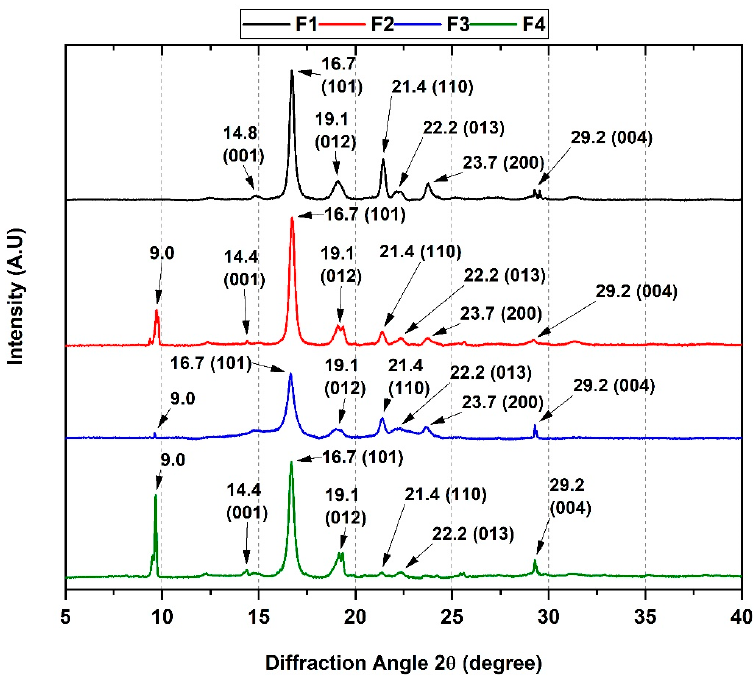
Figure 8. XRD analysis of PCL/PLA/ZnO-NPs/Gly/TTEO nanocomposites. F1, 25%PCL/70%PLA/5%Gly; F2, 22%PCL/70%PLA/5%Gly/3%ZnO-NPs; F3, 15%PCL/70%PLA/5%Gly/10%TTEO; F4, 17%PCL/70%PLA/5%Gly/3%ZnO-NPs/10%TTEO. On the other hand, changes in the crystallinity of the F2, F3, and F4 membranes were observed. Firstly, adding ZnO-NPs promotes degradation by decreasing the nucleation processes, generating greater mobility of the polymer chains, and causing new diffraction sites such as the 2 θ shift at 9° [44]. Secondly, the introduction of TTEO caused a decrease in the resolution and intensity of the diffraction peaks due to a change in the crystallinity; this observation suggests that TTEO reduces the intramolecular hydrogen bonding inter- actions generating intermolecular spaces along the polymer chains [43]. 3.6. Scanning Electron Microscopy (SEM) of PCL/PLA/ZnO-NPs/Gly/TTEO Nanocomposites Figure 9 shows the electron micrographs of the different membranes. The surface micrographs of the membranes show a porous drop-matrix structure that allows interac- tion with new components due to the incompatibility between the phases, especially F1. Additionally, as observed in previous works, the F2 formulation presents an increase in